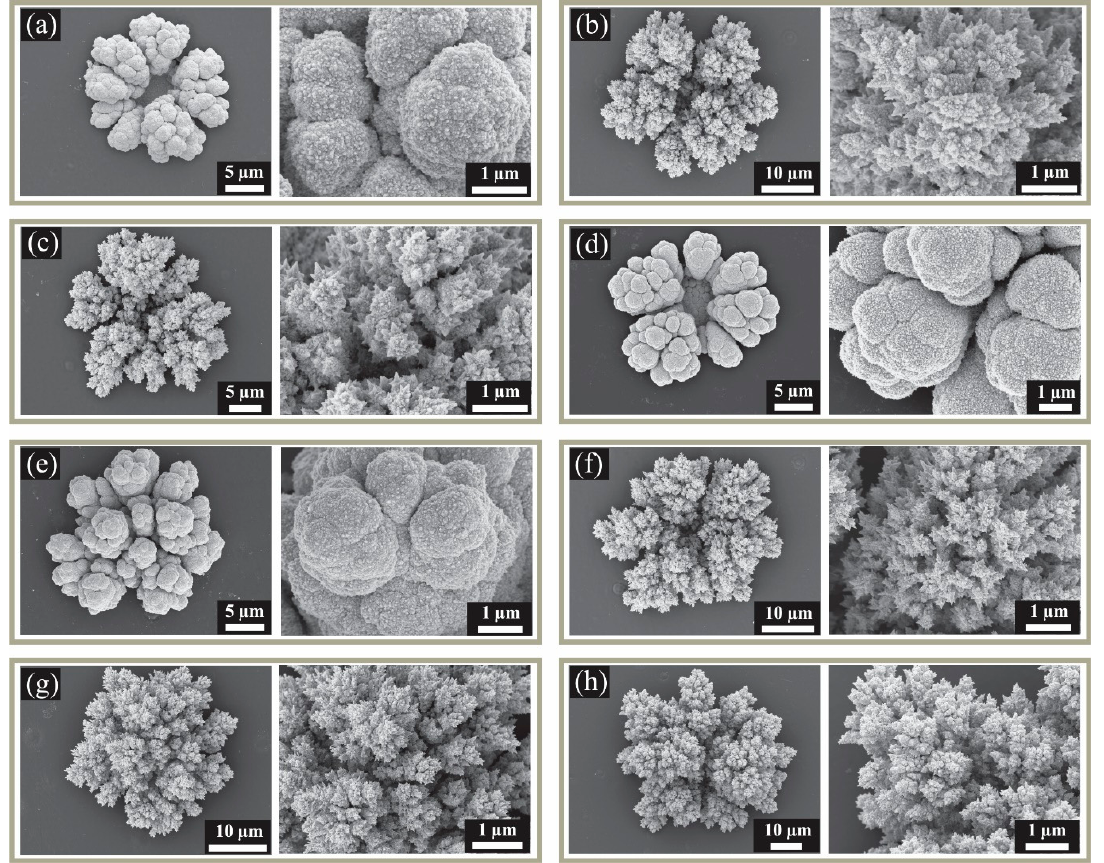
Figure 2. Scanning electron microscopy (SEM) images for the different nanostructured MATFEs with corresponding zoomed-in images showing the fine detail. ( a ) 300 s Pt, ( b ) 300 s Pt/Pb, ( c ) 150 s Pt/Pb + 150 s Pt/Pb, ( d ) 420 s Pt, ( e ) 300 s Pt + 120 s Pt, ( f ) 420 s Pt/Pb, ( g ) 300 s Pt + 120 s Pt/Pb, ( h ) 300 s Pt/Pb + 120 s Pt/Pb.